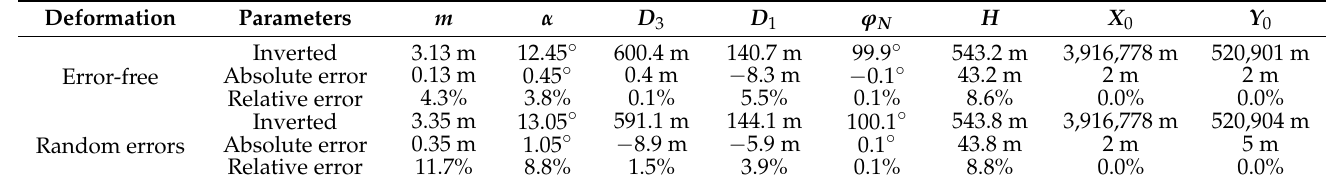
Table 5. Comparison between the inversion results without errors and with random errors in deformation.